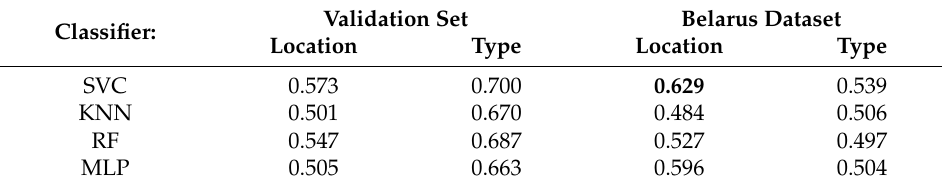
Figure 9. Drug Resistance Classification—AUC performance on sextants. Table 5. Performance when location and type are separated for annotated radiologic